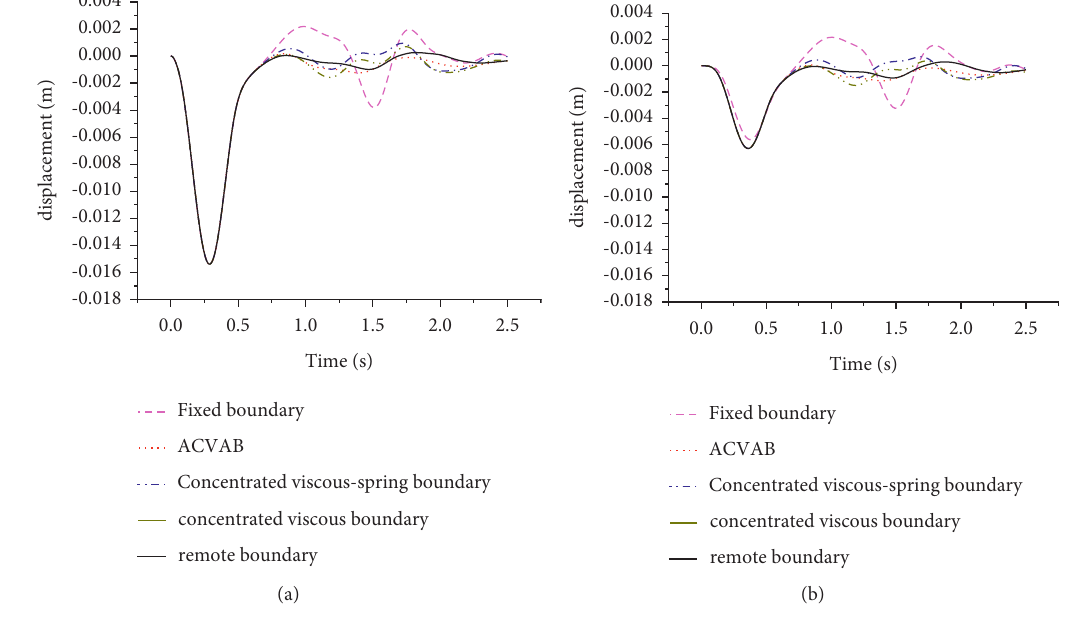
Figure 9: Displacement time history of observation points: (a) Point A and (b) Point B. Table 3: Advantages and disadvantages of artificial boundary.